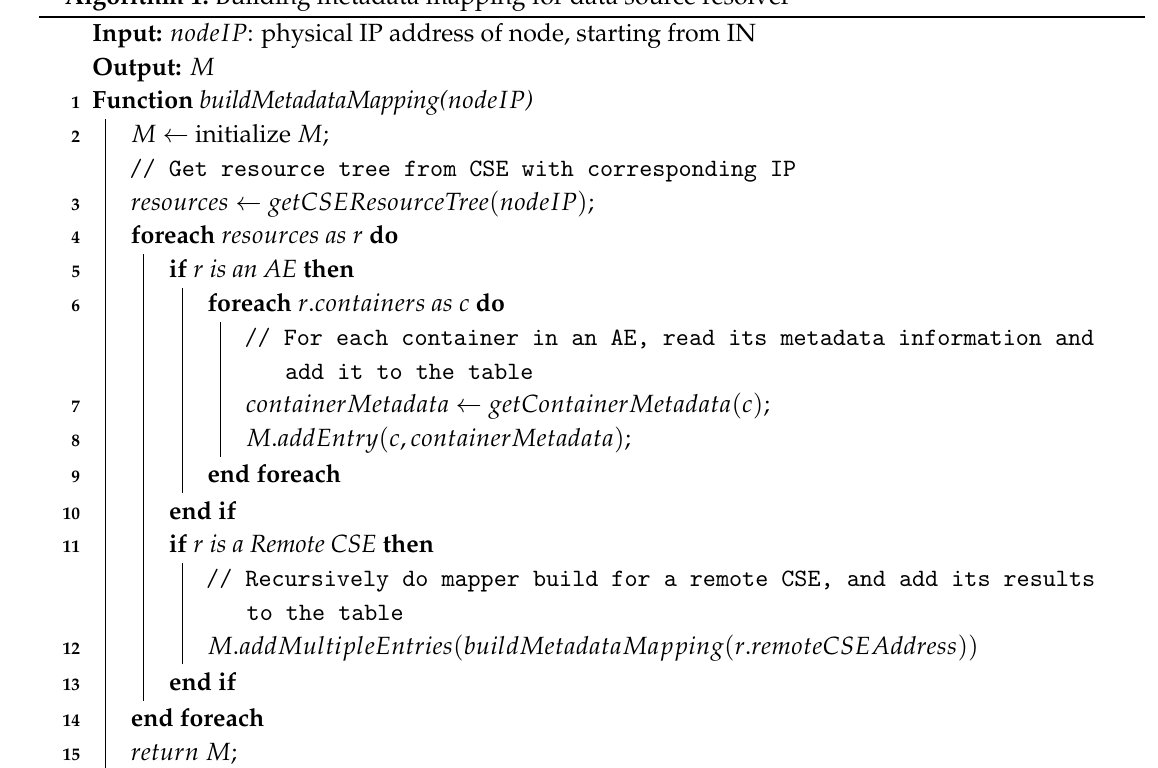
Algorithm 1: Building metadata mapping for data source resolver